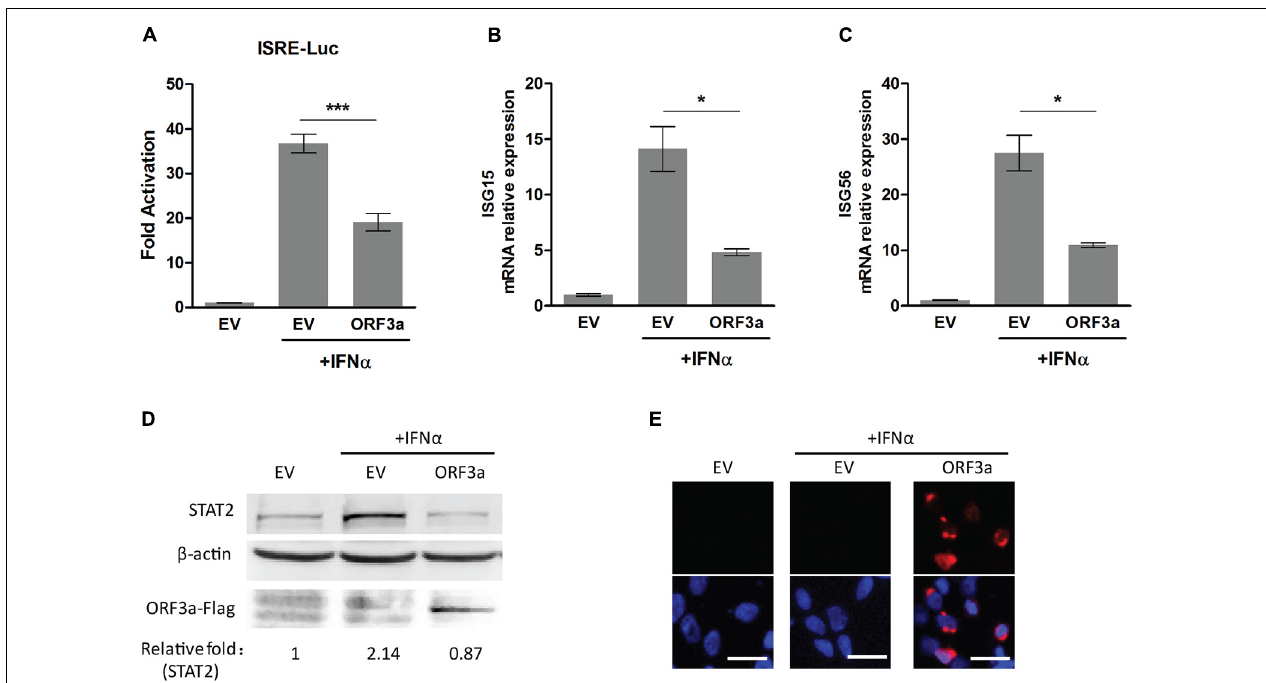
FIGURE 1 | Severe acute respiratory syndrome coronavirus 2 accessory protein ORF3a inhibits IFN-activated JAK/STAT signaling. (A) ISRE luciferase reporter assay. HEK293T cells were cotransfected with ISRE-Luc reporter plasmid, pGL4.74 hRL-TK plasmid, and empty vector (EV) or expression plasmid of SARS-CoV-2 ORF3a. At 24 h post-transfection, the cells were mock-treated or treated with IFN α (500 U/mL) for 20 h and then subjected to Dual-Luciferase reporter assay. The fold activation was determined compared to that of the EV with mock-treated cells. (B–D) The expression levels of ISG15, ISG56, and STAT2 in HEK293T cells with ORF3a plasmid transfection. HEK293T cells were transfected with a plasmid expressing ORF3a for 24 h. Then, the cells were treated with IFN α . ISG15 (B) and ISG56 (C) mRNA levels were determined at 13 h after the IFN treatment by RT-PCR. STAT2 levels were detected at 20 h after the IFN treatment by immunoblotting (D) . Relative levels of STAT2 are shown as folds below the images after normalization with β -actin in densitometry analysis. (E) Expression of ORF3a plasmid in HEK293T cells was confirmed by immunofluorescence staining with antibody against Flag. The upper panel shows ORF3a expression, and the lower panel shows an overlay of protein expression and DAPI staining. Bars in the images denote 20 µ m. Significant differences from the IFN-treated EV control are denoted by “*” and “***”, which indicate P < 0.05 and P < 0.001, respectively. Error bars represent standard errors of the results of repeated